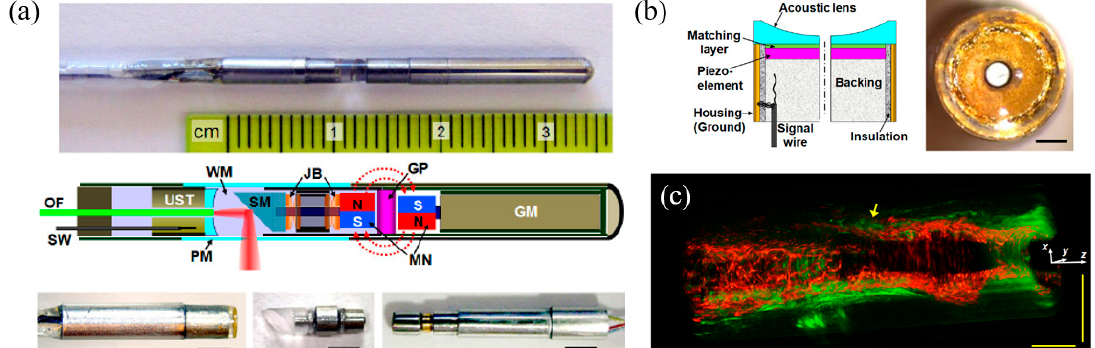
Figure 15. ( a ) Photograph (top) and schematic (middle) of the integrated photoacoustic / ultrasound imaging probe, and detailed photograph (bottom) of an optical fiber and ultrasound transducer unit, a scanning mirror unit, and a micromotor unit. ( b ) Schematic (left) and photograph (right) of the PMN-PT based transducer. ( c ) Three-dimensional (3D) rendered photoacoustic / ultrasound image of a rat colon (Reproduced with permission from OSA [70]). OF: optical fiber, SW: signal wire, UST: